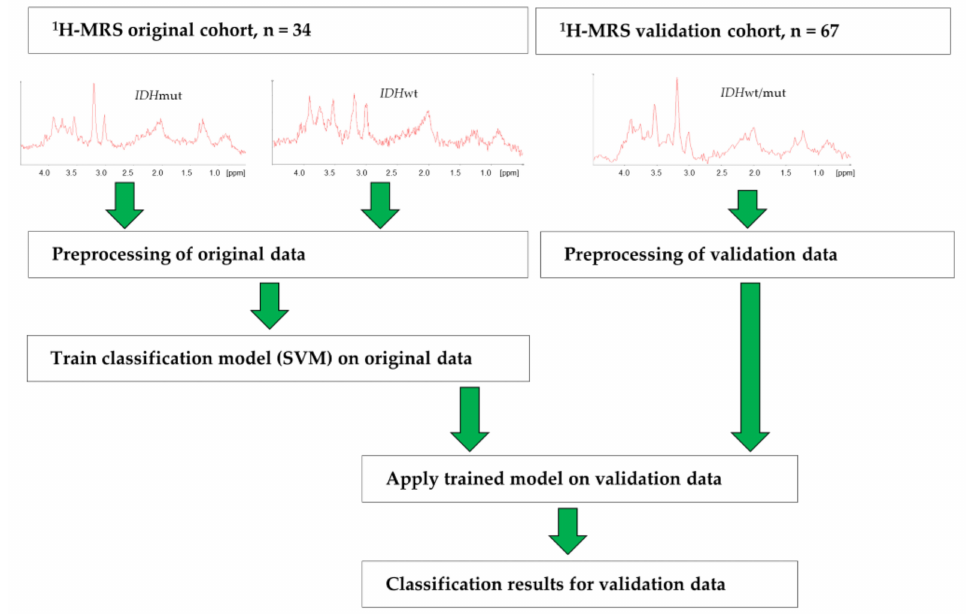
Figure 2. Workflow of data collection and analysis in the original and validation cohort. 1 H-MRS: 1 H- magnetic resonance spectra; IDH : isocitrate dehydrogenase ; mut: mutated; wt: wildtype; SVM: support vector